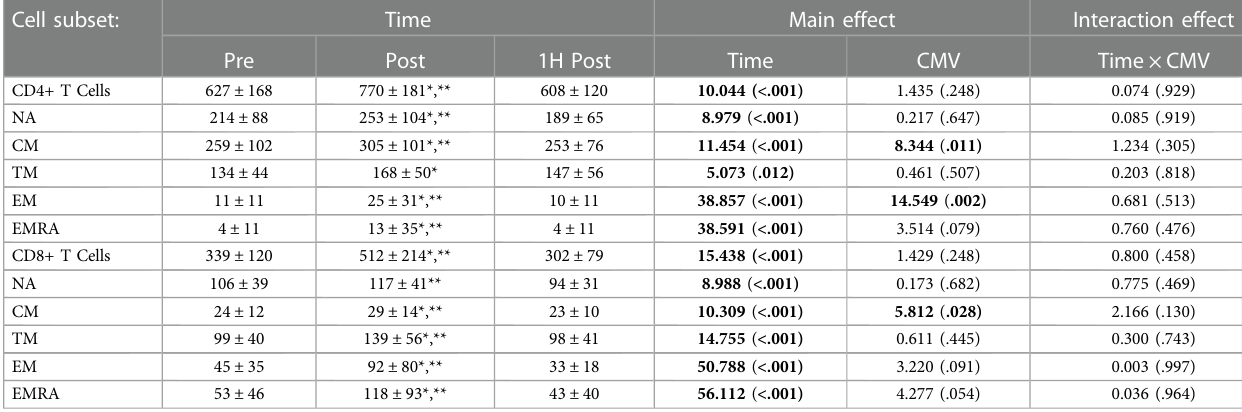
TABLE 3 Theconcentration(cells/µl)of CD4+and CD8+ T cell subsets present in peripheral blood Pre-, post-, and 1Hpost-exercise. Values are means± S.D.; Main effects are F-statistic ( p -value). Cell